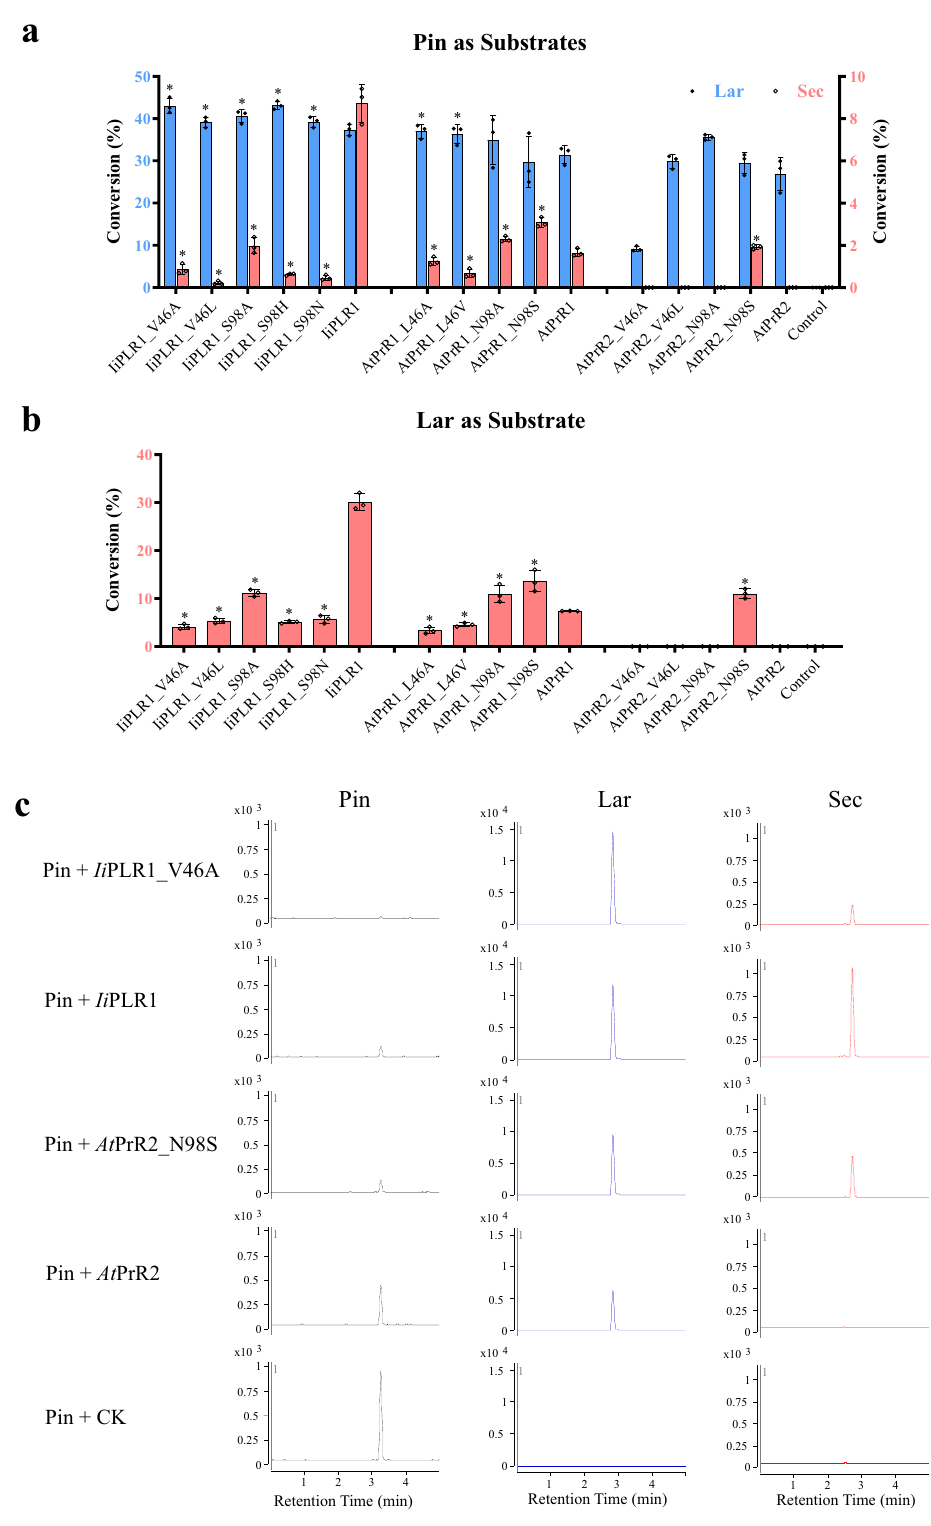
Fig. 4 Percent conversion of pinoresinol to lariciresinol and subsequently to secoisolariciresinol by mutants of Ii PLR1, At PrR1 and At PrR2. a Conversion of pinoresinol into lariciresinol and subsequently to secoisolariciresinol. b Conversion of lariciresinol into secoisolariciresinol. Data are mean